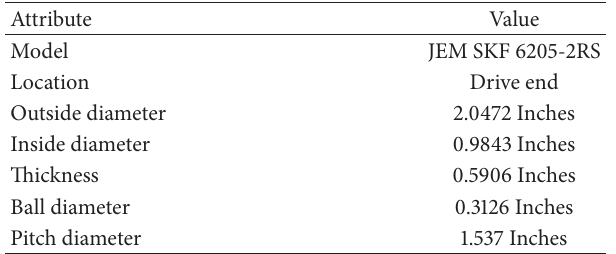
Table 1: Specifications of bearings.